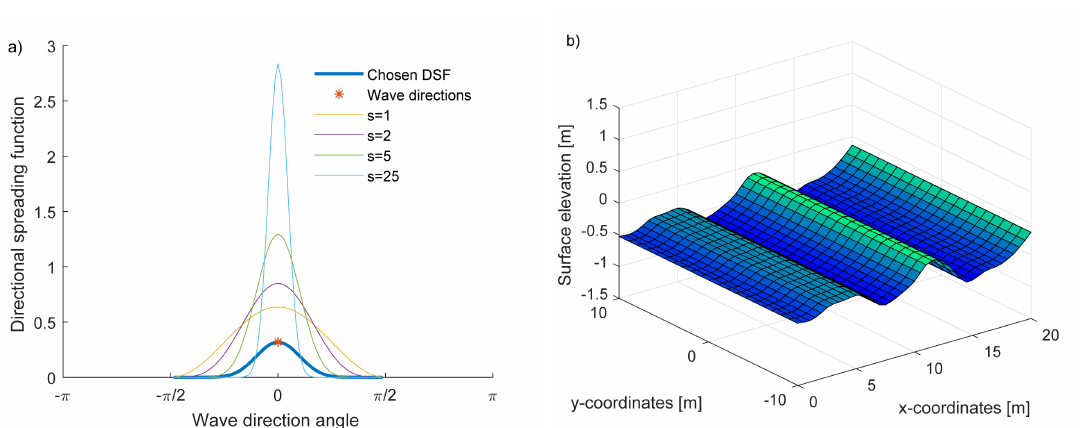
Figure 2. ( a ) Directional spreading function and ( b ) surface elevation of a long-crested, unidirectional wave, to be compared against the short-crested waves in Figures 3–5. For the case of only one wave direction χ = 0, the value of the spreading parameter is irrelevant as cos 2 s ( 0 ) = 1 for any values of s . The factor F ( s ) in Equation (24) equals F ( s ) = 1/ π in the case of a single wave direction, which guarantees normalization in Equation